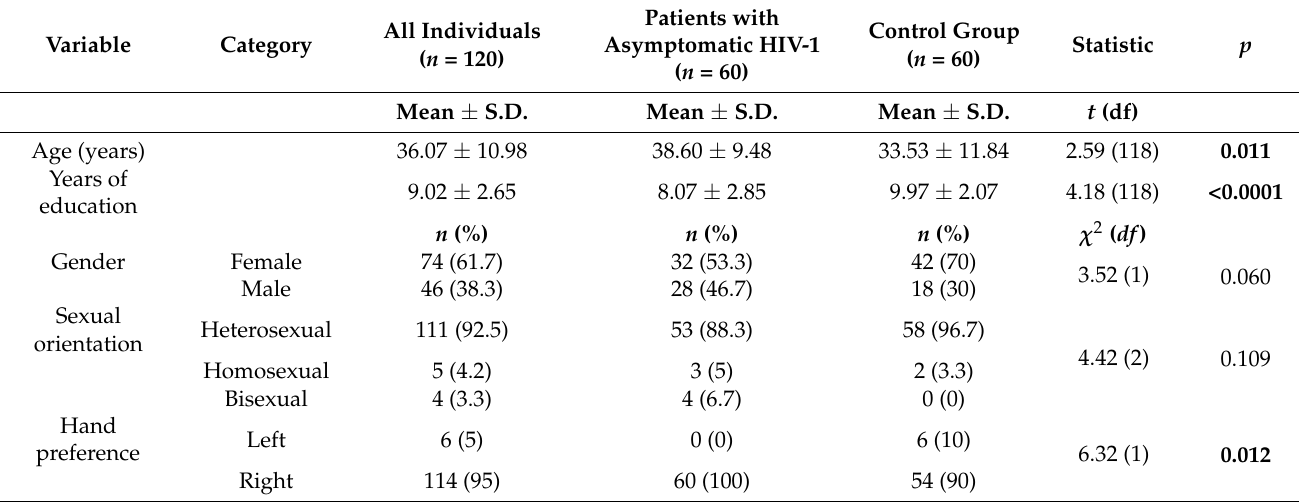
Table 1. Demographic characteristics of